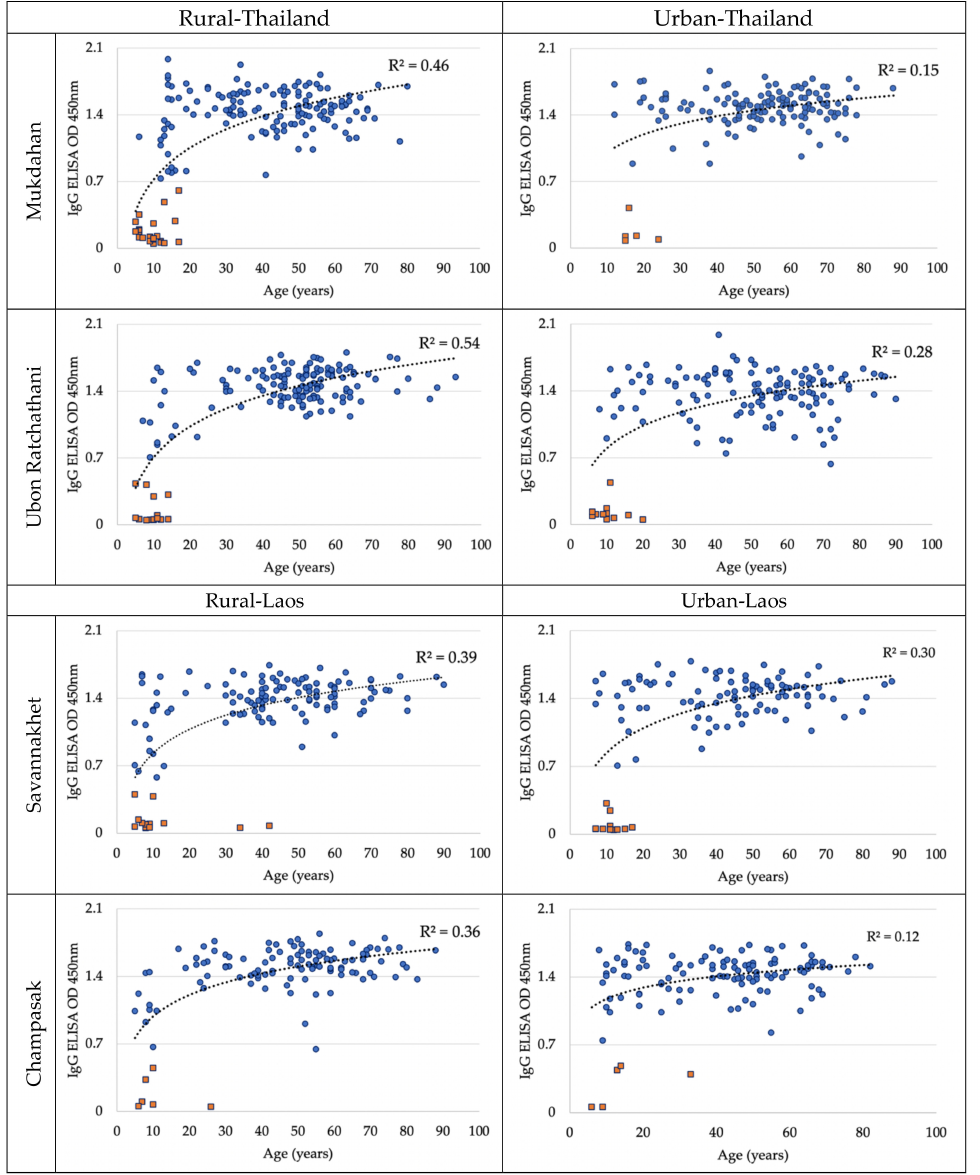
Figure 2. Distribution of dengue IgG enzyme-linked immunosorbent assay (ELISA) optical density (OD) values by age (blue dots denote the OD seropositive and orange dots denote the OD seronegative individuals) in urban and rural of Thailand (upper panels) and in Laos (lower panels) in May 2019. Shown is a logarithmic tendency